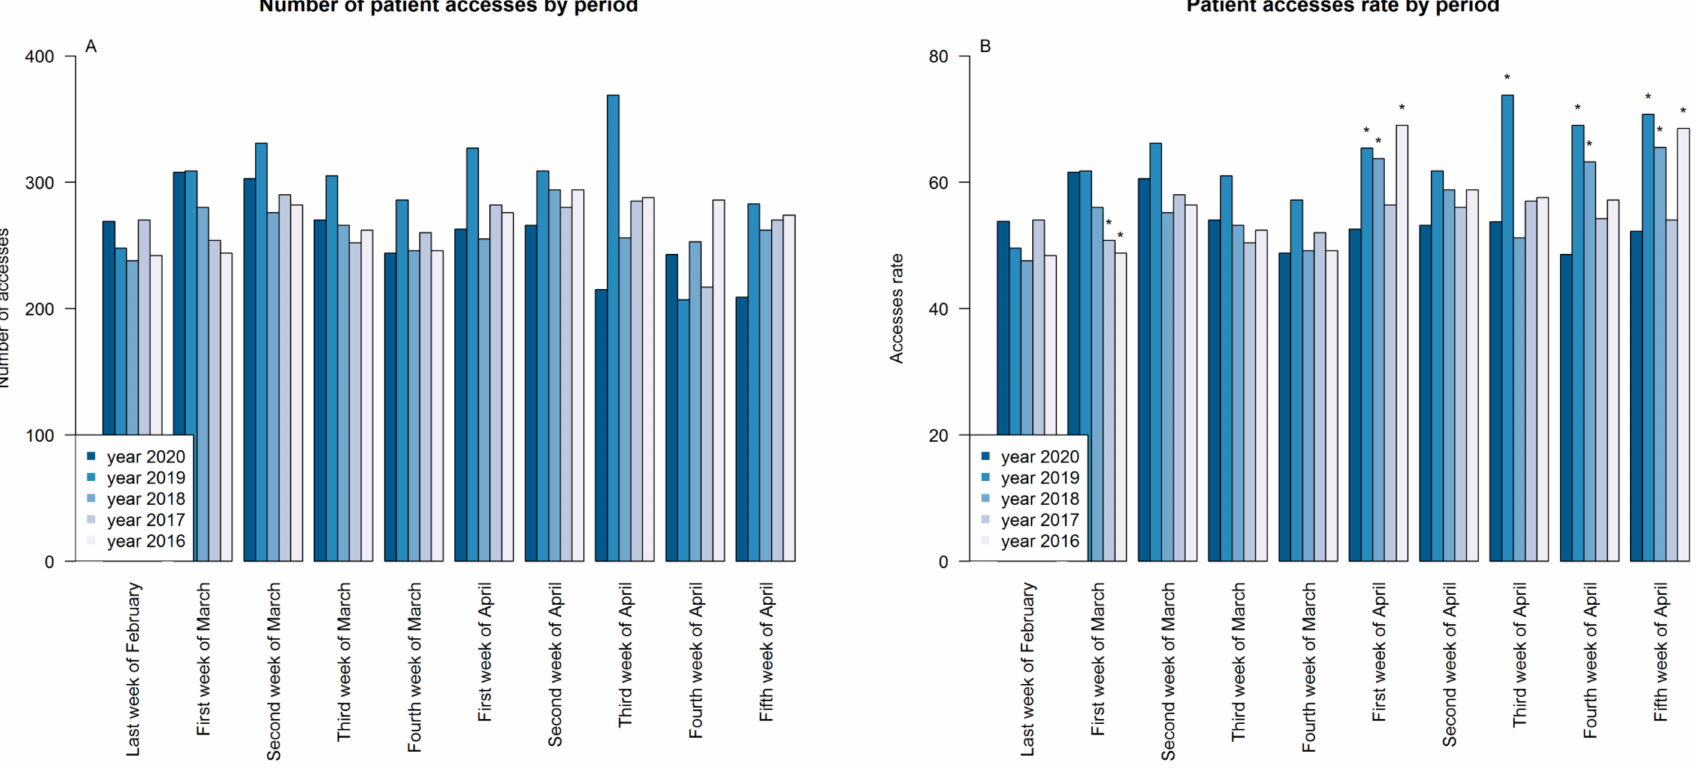
Figure 2. Absolute frequency of patient accesses ( A ) and patient accesses rate ( B ) by period. * Indicates statistically significant di ff erences between access rates during 2020 and the considered